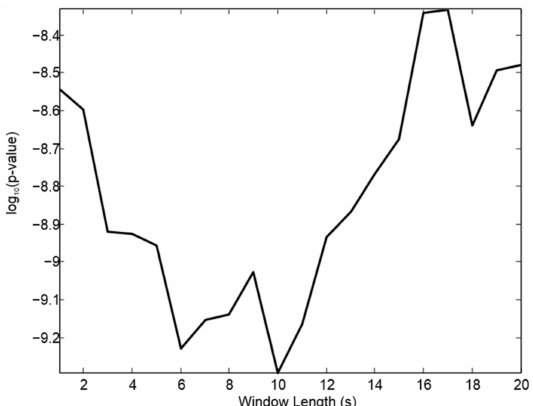
Figure 3. Influence of window length on the overall separability of subjects with pulmonary artery hypertension and without. A two-sample independent t -test was used, and reported p -values are corrected using Holm-Bonferroni method. We plotted the window length against the log to base 10 function of the corrected p -value to highlight the optimal length value.